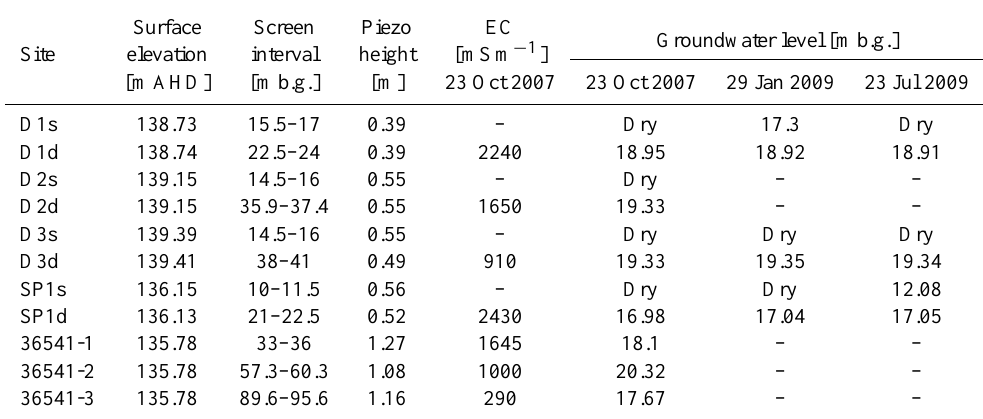
Table 1. Summary of piezometers installed (1–2 September 2007), monitoring bore 36541 (NSW Office of Water), groundwater salinity (EC) and groundwater